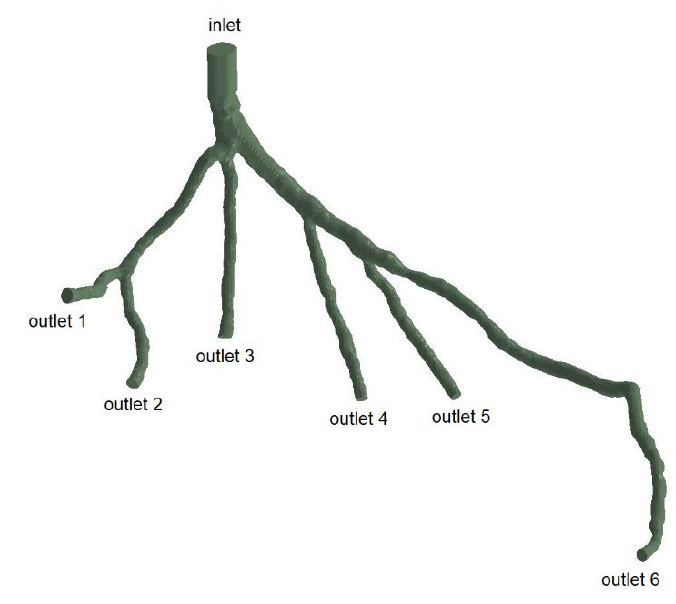
Figure 4. Geometry of inlet and outlets of the CHN13 model.